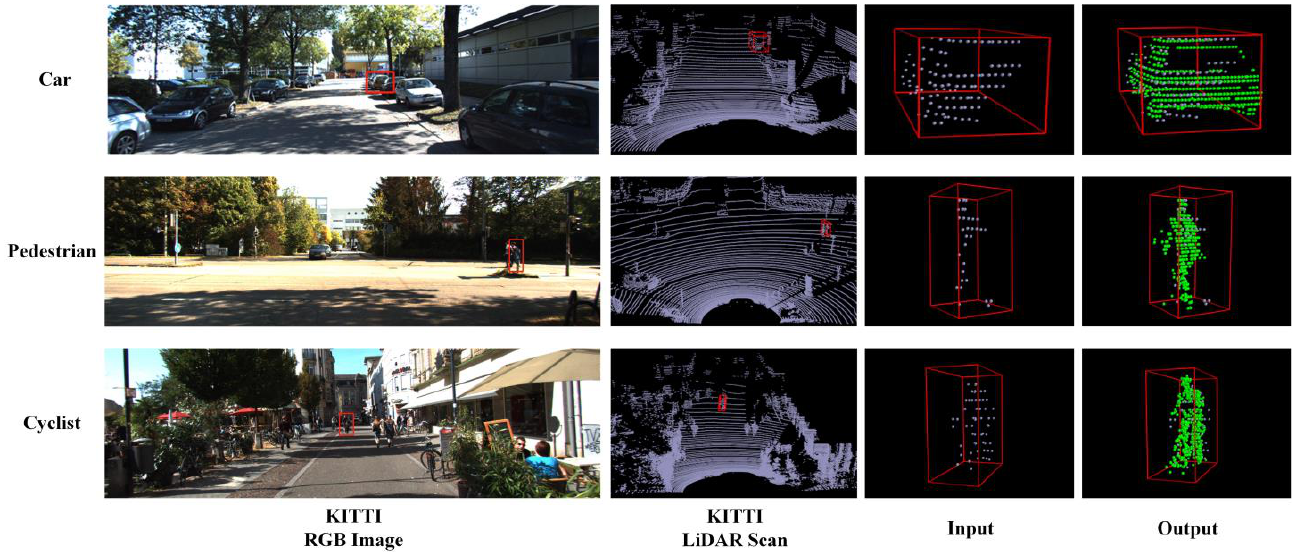
Figure 9. Visualization of the reconstructed target. The first column is the RGB image of the real scene. The second column is the LiDAR scan. The third column is the incomplete point cloud extracted from the real scene. The fourth column is the reconstruction result.